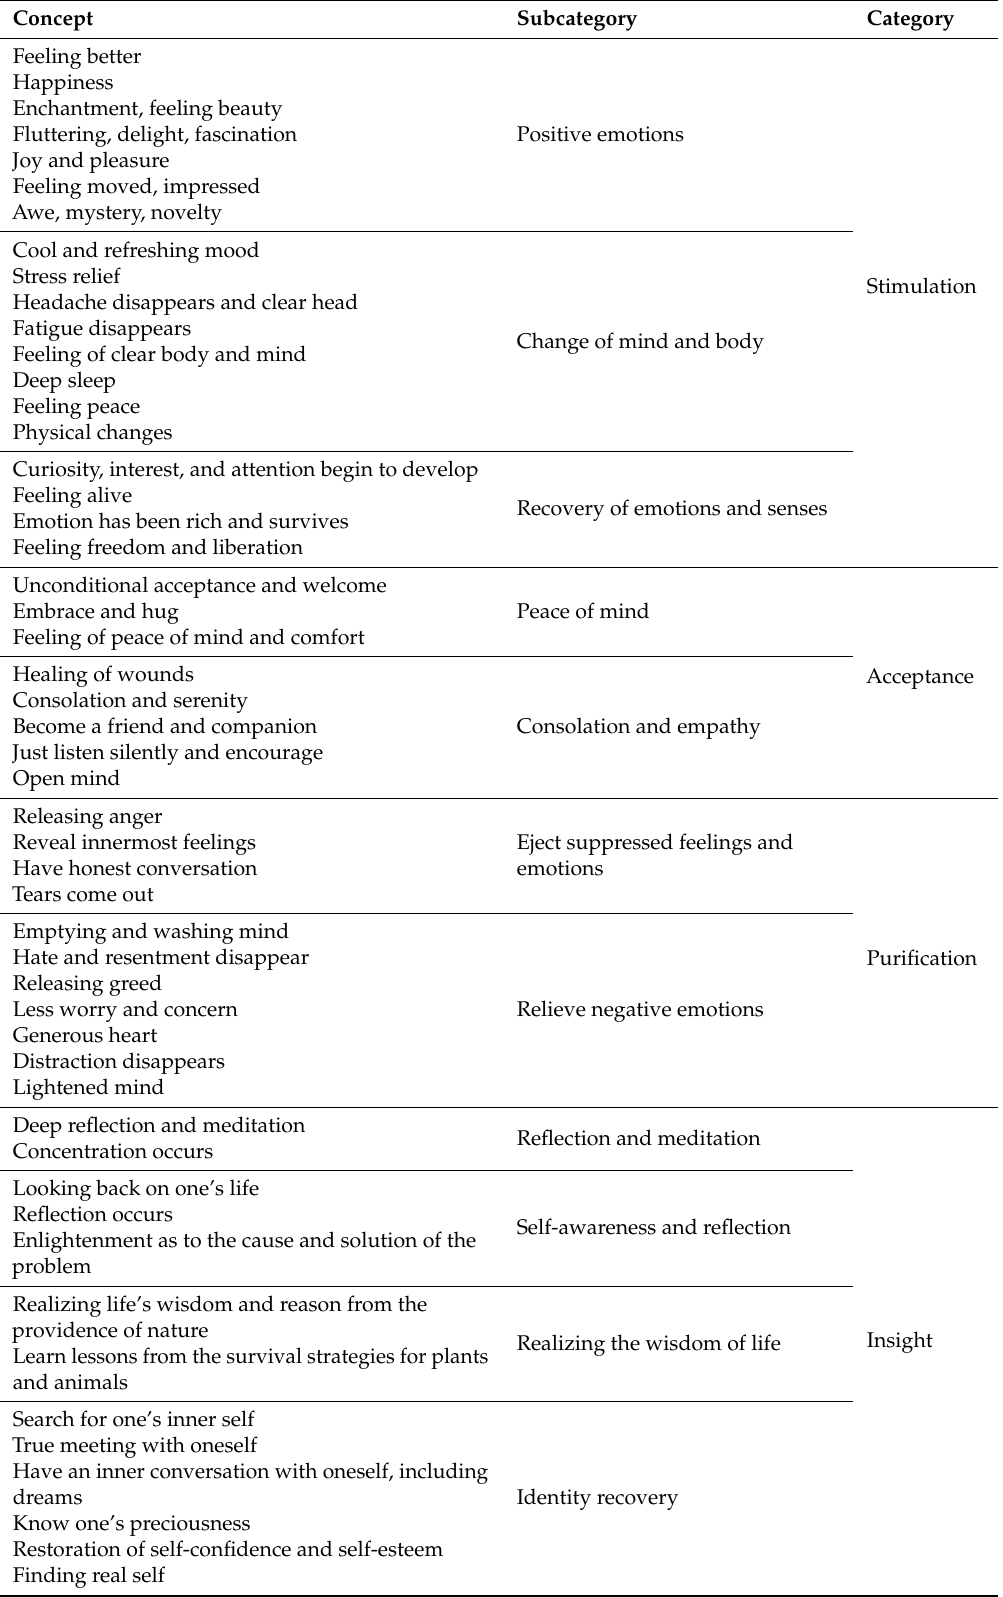
Table 2. Concepts and